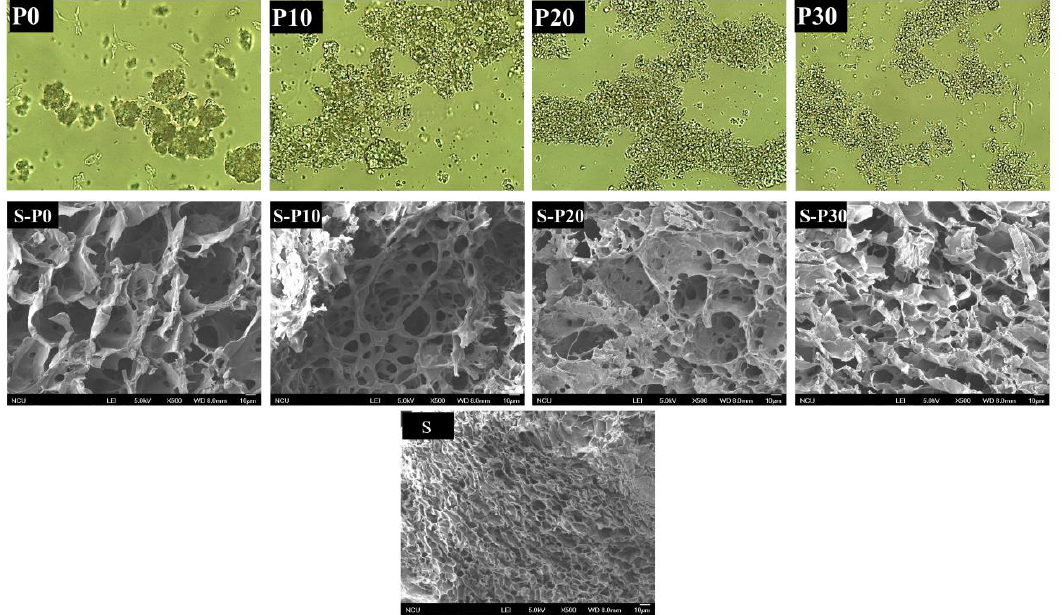
Figure 2. The optical microscope (P0, P10, P20 and P30) and scanning electron microscopy (S, S-P0, S-P10, S-P20 and S-P30) of different samples. P0, rice protein; P10, P20 and P30 represented the rice protein blend with homogenization for 0, 10, 20 and 30 min, respectively. S, rice starch; S-P0, S-P10, S-P20 and S-P30 represented the rice starch blend with rice protein homogenized for 0, 10, 20 and 30 min, respectively.